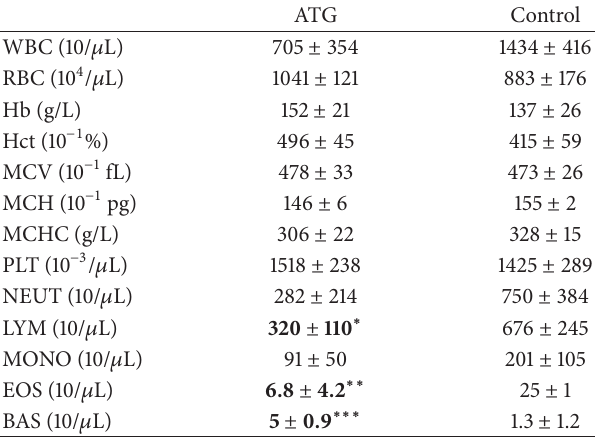
Table 2: Effect of ATG treatment on haematologic parameters in adult BALB/cOlaHsd mice ( 𝑛 = 3 ). ATG Control